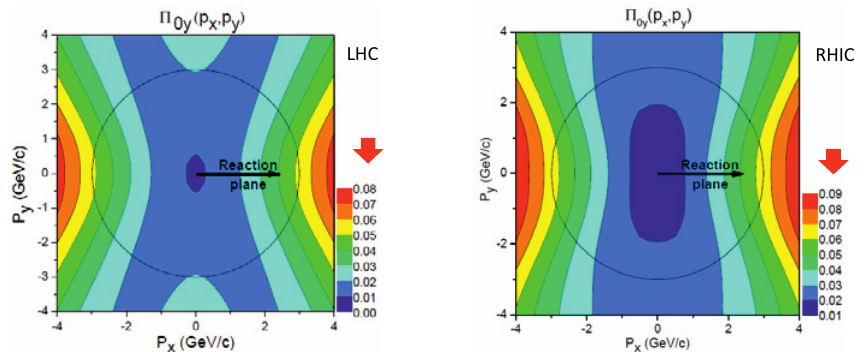
Figure 6. The polarization of the Λ and ¯ Λ particles observed in di ff erent directions and at di ff erent transverse momenta in the transverse, [ x ,y ] plane at the event-by-event c.m. rapidity for RHIC and LHC energies. Signifi- cant polarization can be measured for particles at larger momenta, p t ≥ 3 GeV / c, in the ± p x directions. Based on ref.